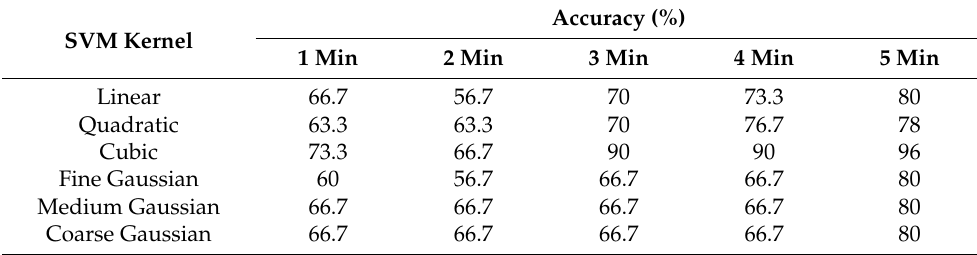
Table 4. Obtained accuracy for each